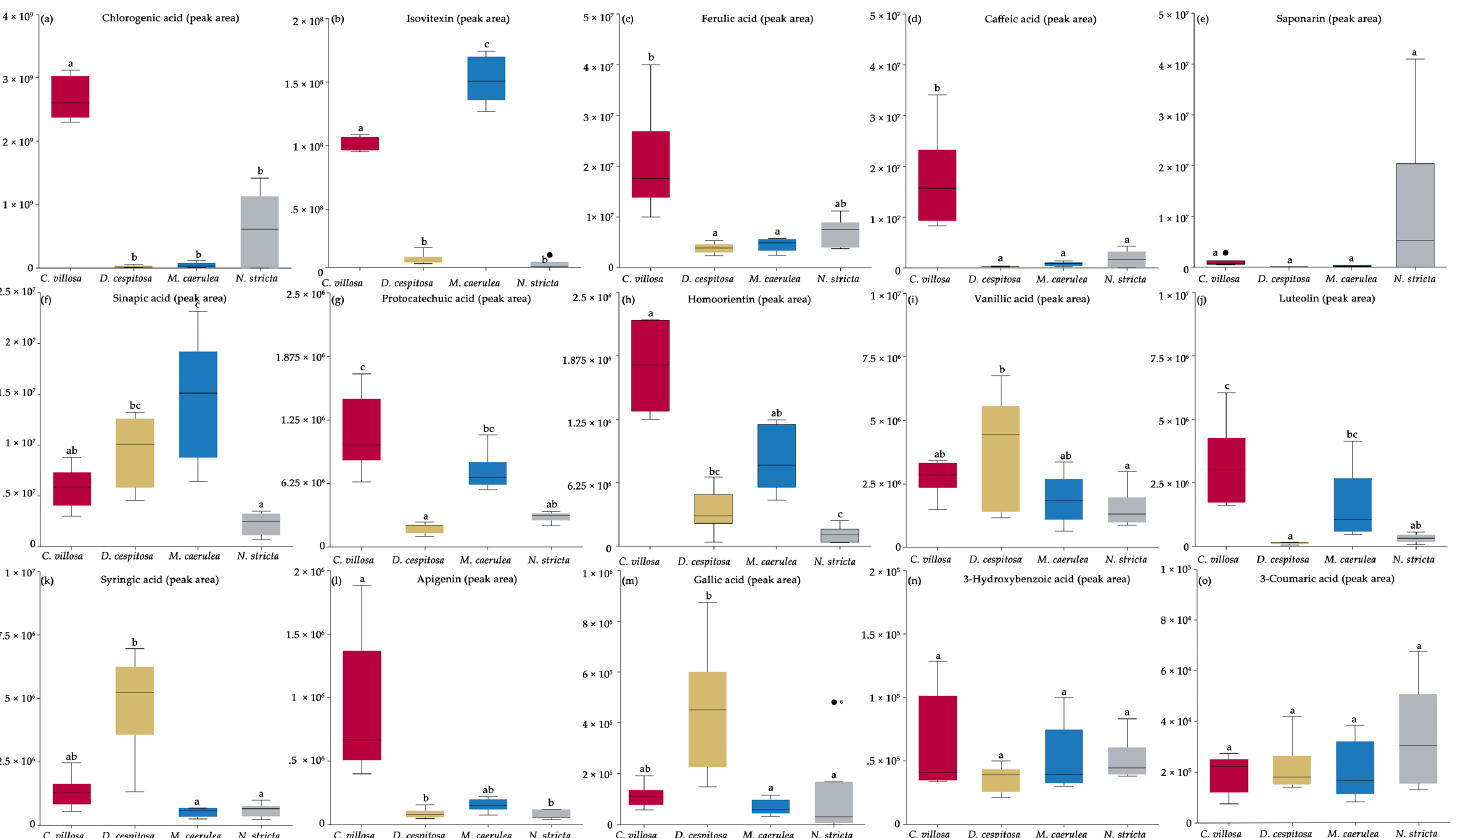
Figure 7. The accumulation of the most abundant phenolics in the four competing grass species from this study: Calamagrostis villosa (red boxes), Deschampsia cespitosa (yellow boxes), Molinia caerulea (blue boxes), and Nardus stricta (grey boxes). The PheC levels are expressed as the peak area corresponding to each PheC normalized based on the peak area of respective standard. Chlorogenic acid ( a ), Isovitexin ( b ), Ferulic acid ( c ), Caffeic acid ( d ), Saponarin ( e ), Sinapic acid ( f ), Protocatechuic acid ( g ), Homoorientin ( h ), Vanillic acid ( i ), Luteolin ( j ), Syringic acid ( k ), Apigenin ( l ), Gallic acid ( m ), 3-Hydroxybenzoic acid ( n ), 3-Coumaric acid ( o ). The means are presented ( n = 6 per species). Different letters of the identical color above boxes indicate statistically significant differences between means (among species) tested by Kruskal–Wallis multiple-comparison Z-value test ( α = 0.05) across species.